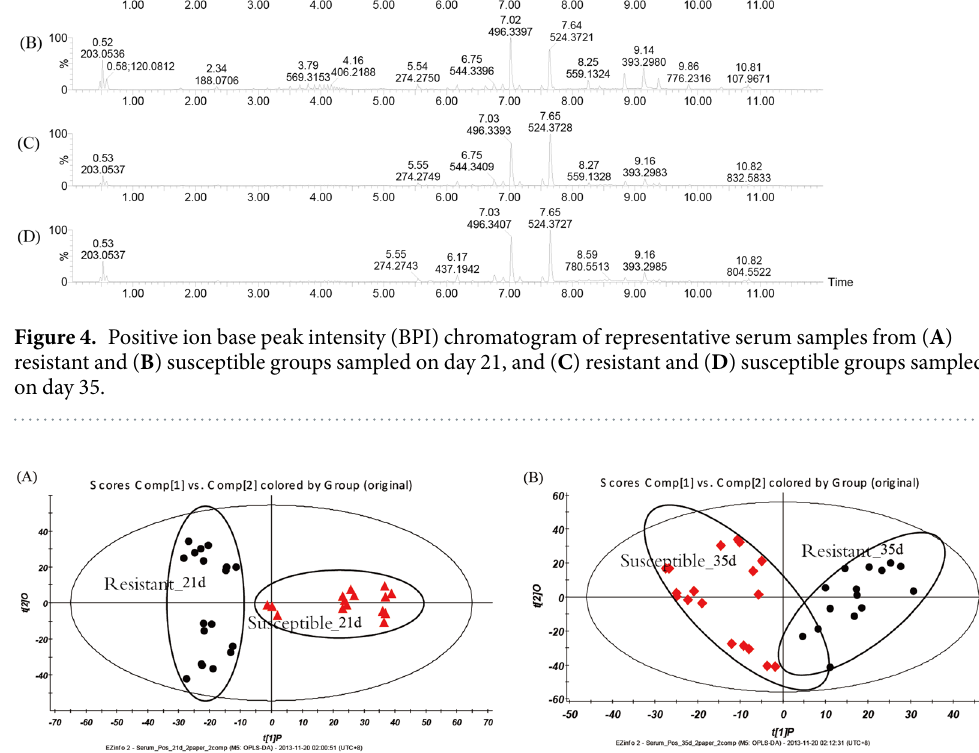
Figure 5. OPLS-DA plots using the scores from the first two principal components, ( A ) exhibiting the scatter between the resistant group and susceptible group on day 21; ( B ) exhibiting the scatter between the resistant group and susceptible group on day